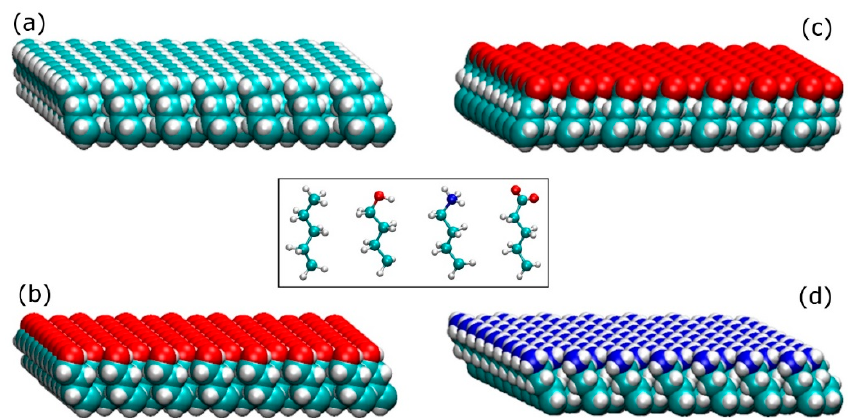
Figure 9. Self-assembled monolayers (SAMs)-replicating model surfaces; ( a ) methyl-terminated ( − CH 3 ), ( b ) hydroxyl-terminated ( − OH), ( c ) carboxyl-terminated ( − COO − ), and ( d ) amine-terminated ( − NH 3 + ). On the inset are shown the building molecules for the SAM replicated model surfaces (from left to right; methyl-terminated, hydroxyl-terminated, amine-terminated, and carboxyl-terminated).